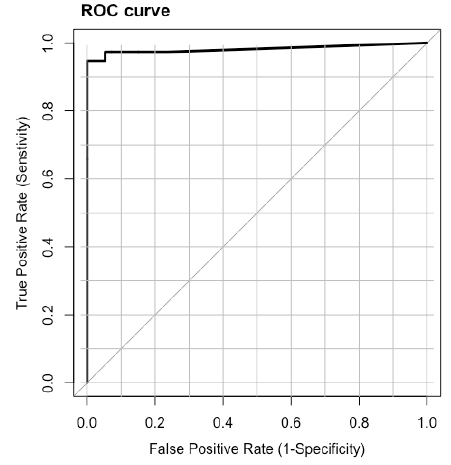
Figure 13. ROC analysis for results shown in Figure 12.